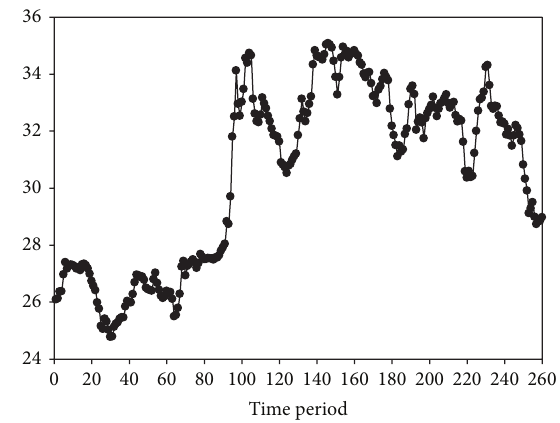
Figure 4: USD/TWD exchange rate time series.